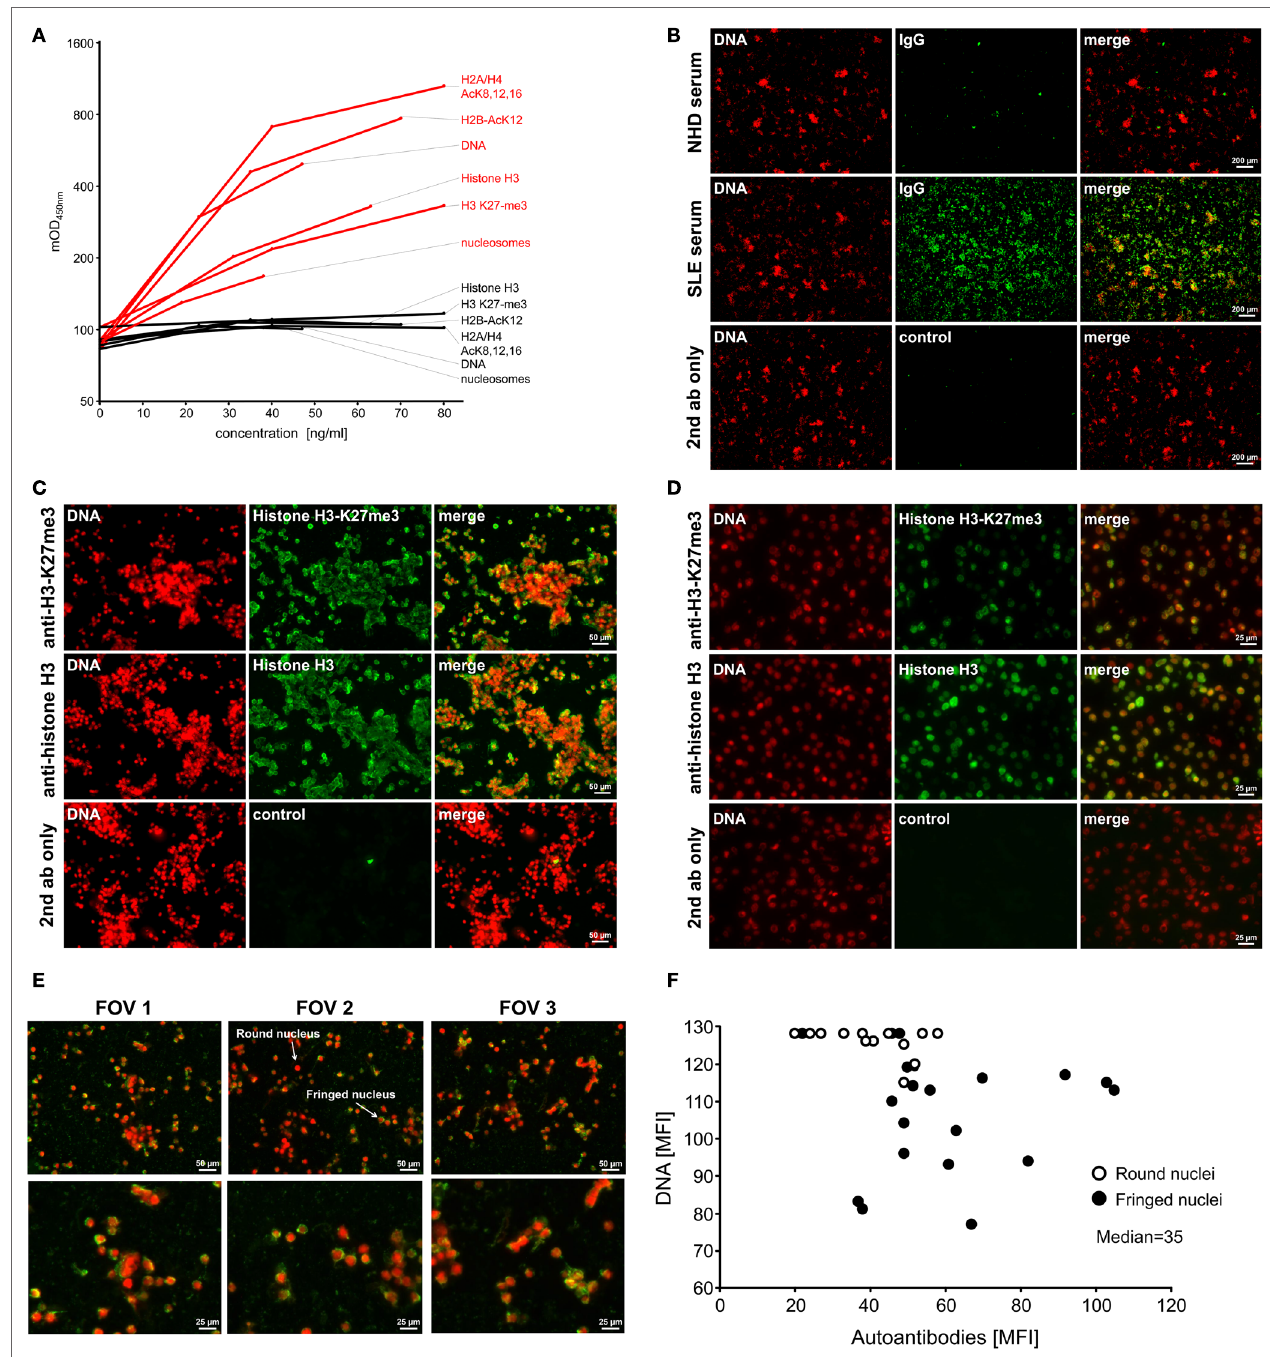
FigUre 1 | Immobilized secondary NEcrotic cells (SNECs) expose naïve and modified nuclear autoantigens. (a) Recognition of immobilized autoantigens on SNEC by specific antibodies. Coated material contained histone H3 (#34), DNA (#42), nucleosomes (BT131), and the apoptotically modified histones H3 K27-me3 (BT164), H2A/H4 AcK8,12,16, (KM-2), and H2B-AcK15 (LG11-2). Respective isotype control antibodies (iso) displayed background signals. (B) Immunofluorescence of SLE-borne IgG autoantibodies (AAb) binding immobilized SNEC counter-stained for DNA by propidium iodide (PI). NHD, normal healthy donor; SLE, systemic lupus erythematosus; magnification 20 × . (c) Immunofluorescence of histone H3 and modified histone H3 K27-me3 on immobilized SNEC counter-stained for DNA by PI; magnification 40 × . (D) Immunofluorescence staining of histone H3 and modified histone H3 K27-me3 on HEp-2 cells. (e) Immunofluorescence of binding pattern of IgG autoantibodies present in the serum of patients with SLE to immobilized SNEC stained for DNA by PI; FOV, field of view. (F) Morphometric evaluation of (e) , intensity of DNA staining versus the intensity of IgG staining.